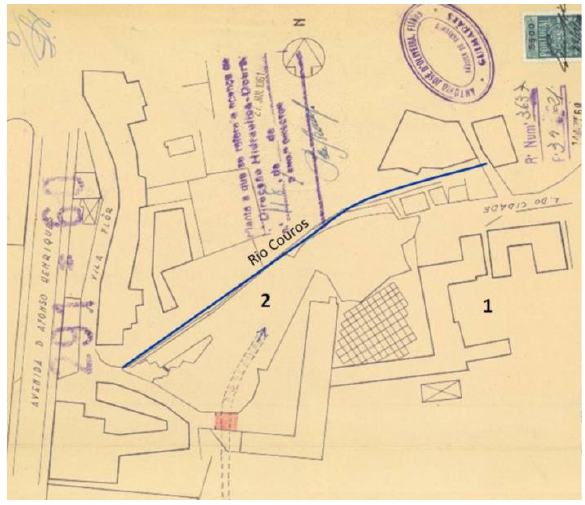
Figure 4. Urban site plan, 1960.